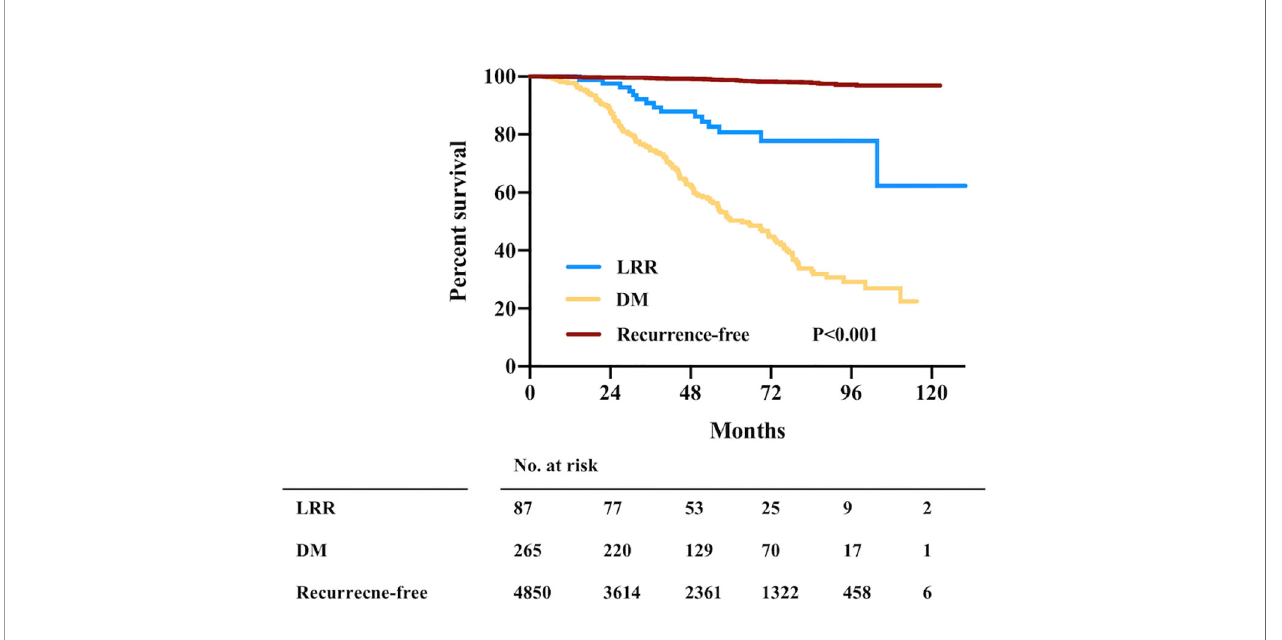
FIGURE 1 | Overall survival by fi rst recurrence event in the whole population. LRR, locoregional recurrence; DM, distant metastasis; No.,